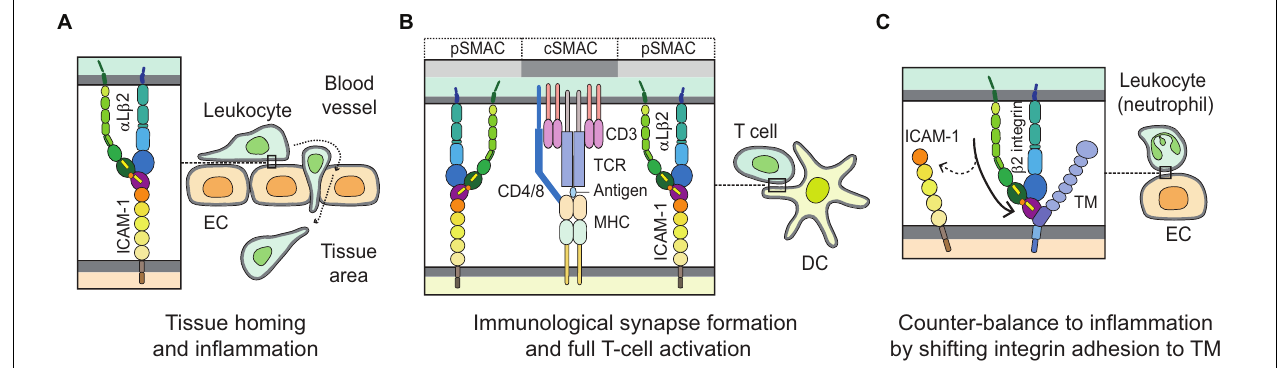
FIGURE 3 | Biological interactions mediated by integrins with ICAM-1 and TM. (A) During leukocyte homing to normal or inflamed tissues, integrin α L β 2 plays a key role by interacting with its cognate ligand ICAM-1 on EC, in mediating slow rolling, firm adhesion and trans-endothelial migration, or extravascular movement. (B) When T cells migrate to the extravascular space in tissue, they probe cognate antigen-presenting DCs and subsequently form stable and mature immunological synapses. In the immunological synapse, the interaction of α L β 2 with ICAM-1 builds up a distinct marginal region called the pSMAC; TCR and auxiliary molecules are enriched in cSMAC, which may empower T cells to become fully activated. (C) The β 2 integrin on leukocytes (e.g., neutrophils) binds to the O-glycosylation-rich domain (D3) of TM on EC. This interaction may help counter-balancing inflammation by shifting adhesion from ICAM-1 to TM. EC, endothelial cell; DC, dendritic